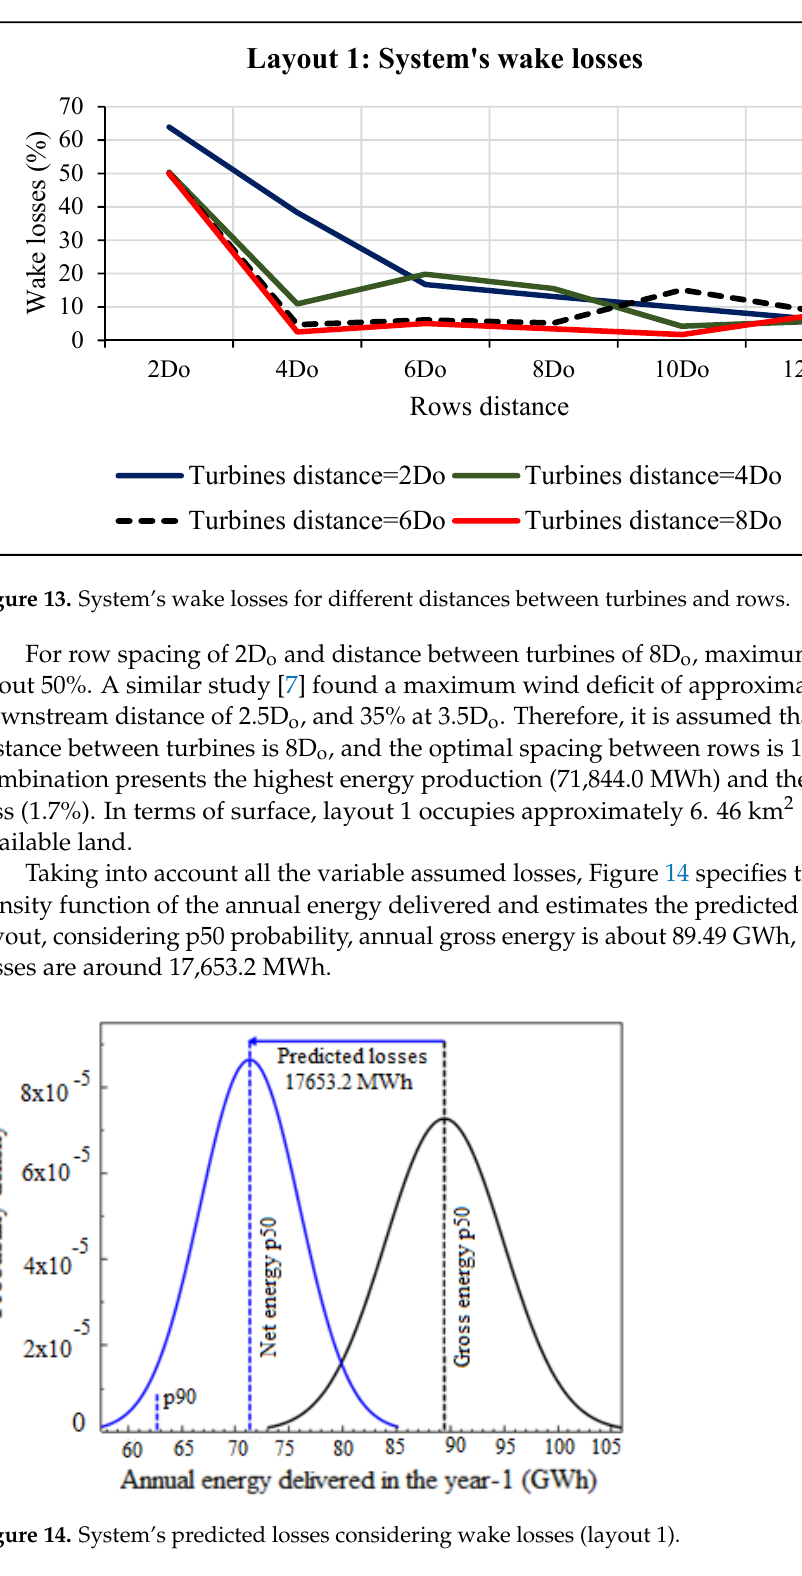
Figure 14. System’s predicted losses considering wake losses (layout 1).